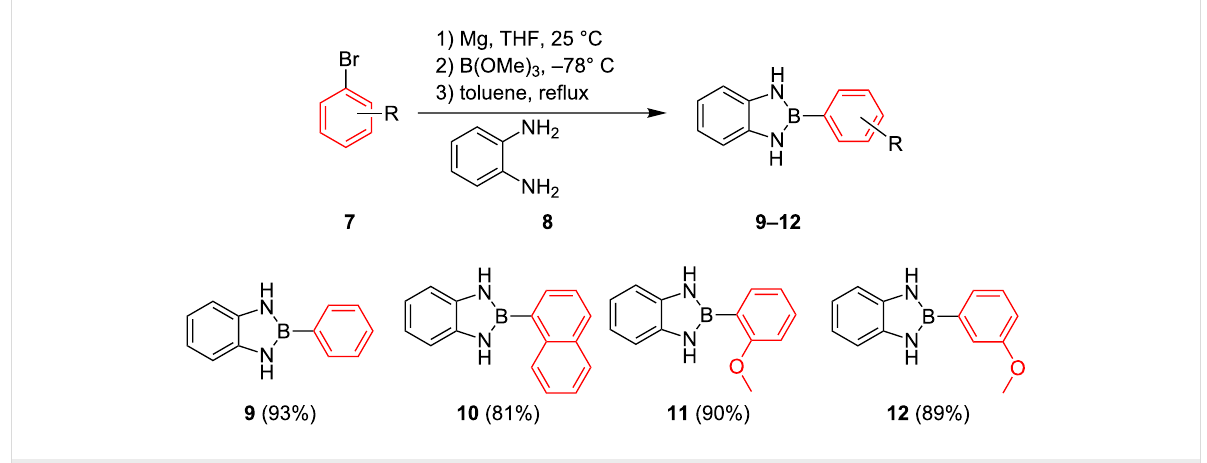
(Table 1). Attempted cross-coupling reaction of compound 9 with bromobenzene ( 13a ), in the absence of both the ligand and a base, gave, as expected, zero conversion of the starting ma- terials (Table 1, entry